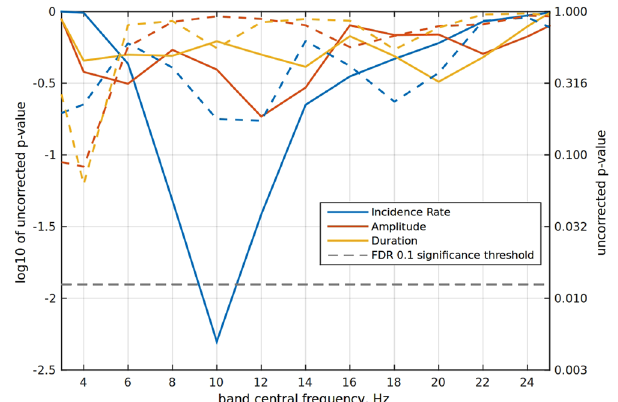
Figure 6. Band specificity study. The plot shows dependence of the main effect’s p – value on the band. Solid lines correspond to the experimental group and the dashed lines to the control group. The significant difference between days in the incidence rate parameter is observed only in the alpha-band and only in the experimental